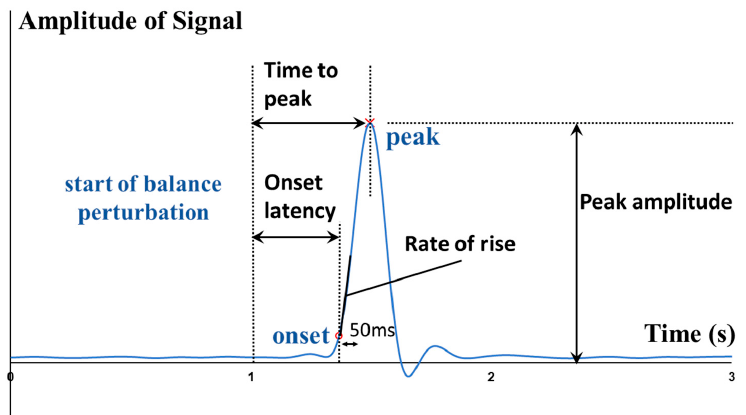
Figure 2. Illustration of the definitions of outcome measures.